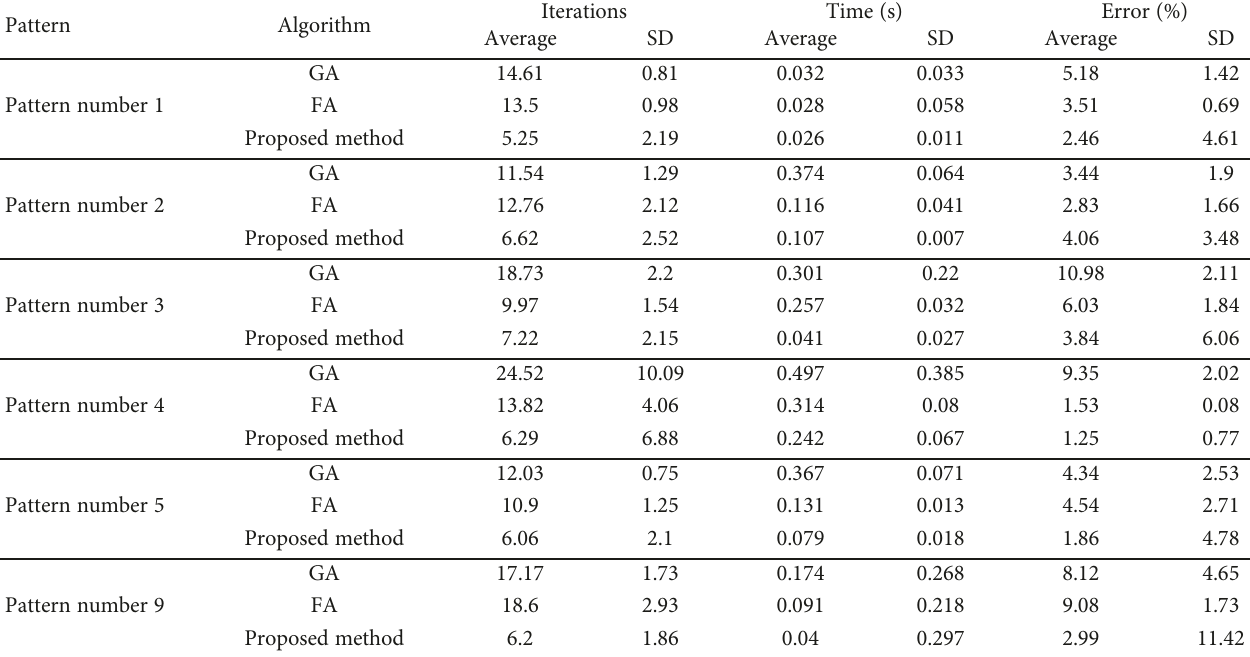
Table 12: Evaluation results of the tracking speed and tracking accuracy.